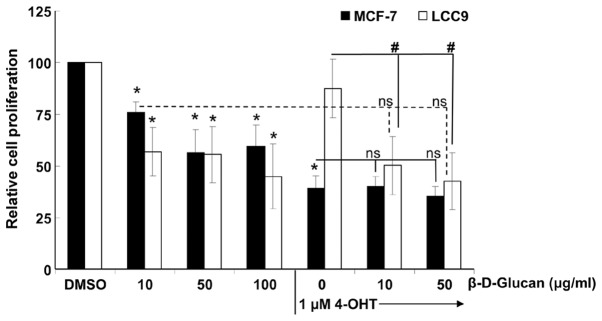
β-D-glucan does not synergize with 4-hydroxytamoxifen to inhibit cell proliferation. MCF-7 tamoxifen-sensitive and LY2 tamoxifen-resistant breast cancer cells were incubated in phenol red-free IMEM + 5% DCC and the indicated concentrations of β-D-glucan dissolved in DMSO, 1 μM 4-OHT, or the combination of 1 μM 4-OHT + 10 or 50 μg/ml β-D-glucan, as indicated, for a total of 72 h with a medium/treatment change after 48 h. Values are the BrdU incorporation absorbances normalized to DMSO (zero) and are the mean ± SEM for 3 separate experiments. Values of β-D-glucan in DMSO were corrected for the inhibitory effect of DMSO on cell proliferation. *p<0.05 vs. control. #p<0.05 vs. 1 μM 4-OHT alone (one-way ANOVA followed by Dunnett’s post hoc test). ns, not statistically different from the same treatment in that cell line, i.e., dotted line indicates that the values for LCC9 with 10 or 50 μg/ml β-D-glucan are not different from the values for LCC9 with 4-OHT + 10 or 50 μg/ml β-D-glucan.